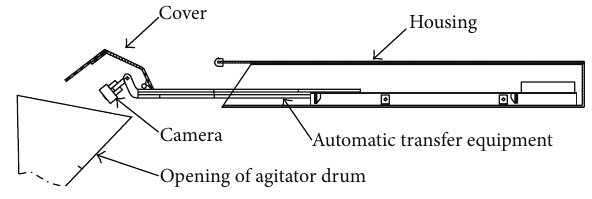
Figure 5: The sharp of image inspection